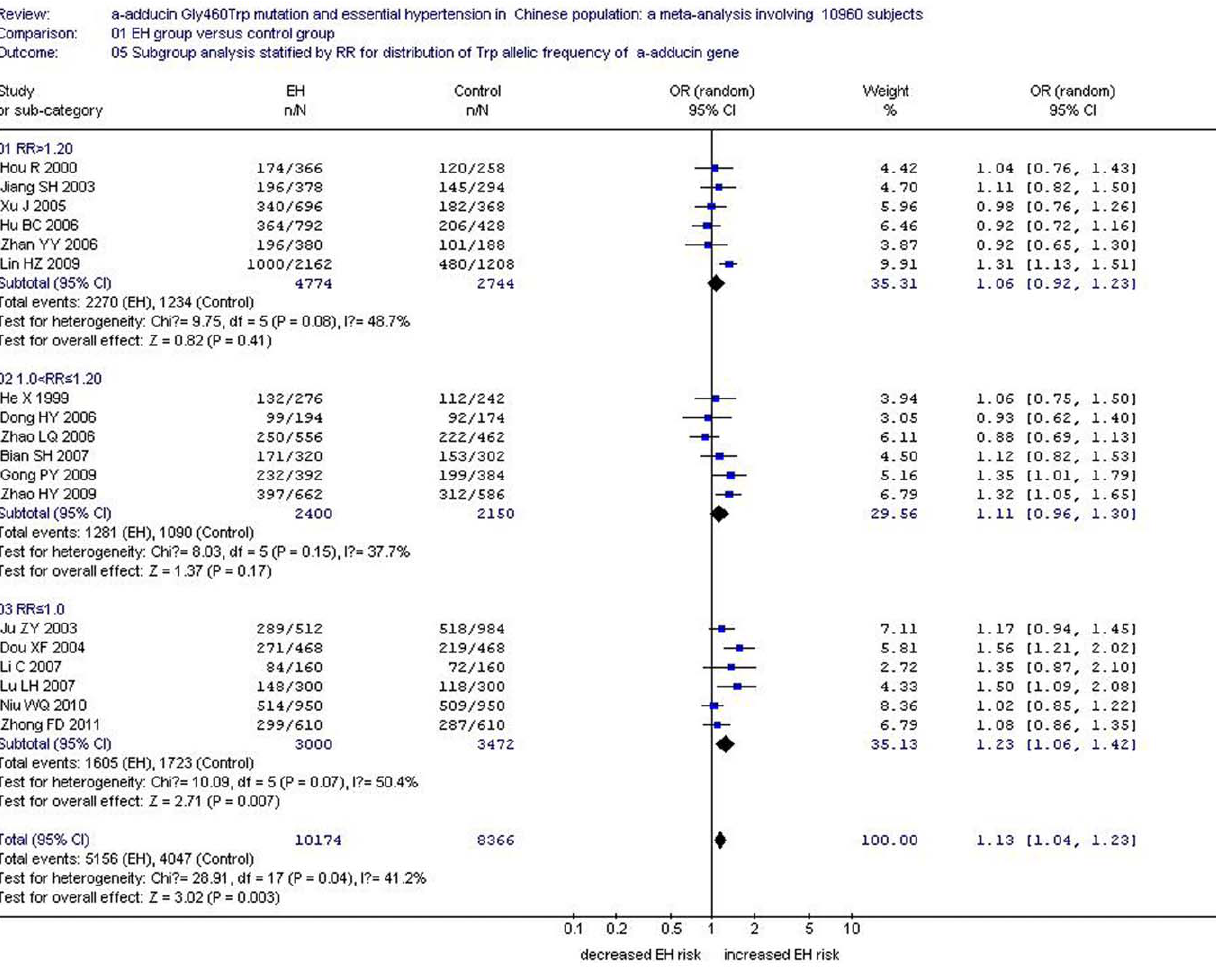
Figure 8. Forest plot of essential hypertension associated with a -adducin Gly460Trp gene polymorphism under an allelic genetic model (distribution of Trp allelic frequency of a -adducin gene) stratified by RR in Chinese Han population. RR: the ratio of case size to control size.